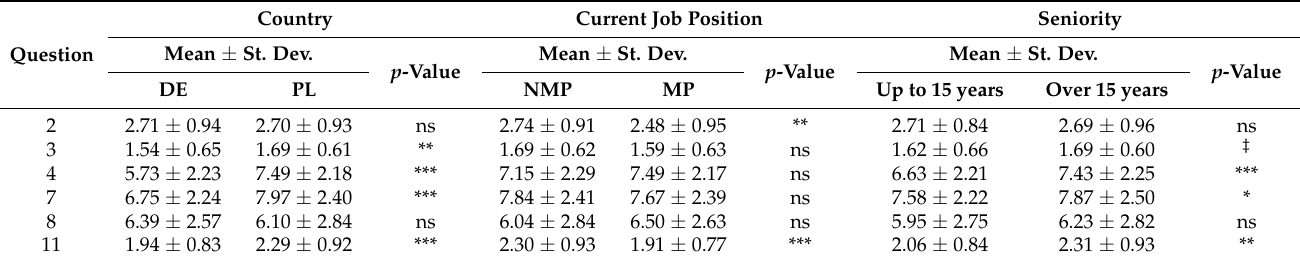
Table 3. Differentiation of opinions in the area of occupational burnout and accompanying phenomena due to selected characteristics of the respondents. Country Current Job Position Seniority Mean ± St. Dev. Mean ± St. Dev. Question p -Value